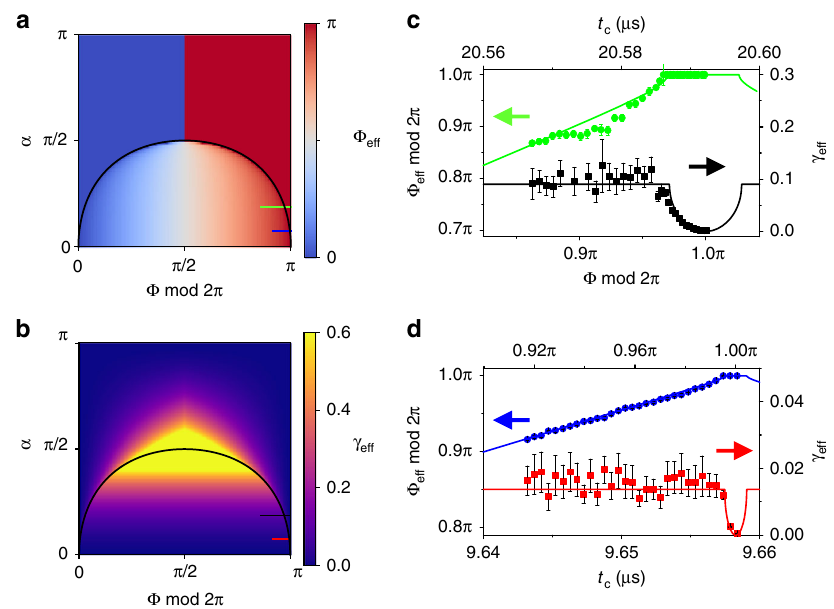
Fig. 3 Quantum dynamics phase transition between oscillating and trapped dynamics. The theoretical results of a the effective precession angle per cycle Φ ¼ 2 π ν t and b the effective decay per cycle γ of the correlation functions versus the conditional phase shift α and nuclear precession angle per (cid:4) (cid:5) eff eff c eff ¼ sin 2 Φ . The short horizontal lines indicate the parameter ranges of measurement cycle Φ ¼ 2 π (cid:2) ν t . The black curves show the phase boundary tan 4 α c 2 the experimental data in ( c ) and ( d ). c The experimental oscillation frequency (green circles) and decay per cycle (black squares) of the correlation ¼ 100), compared with the theoretical results (curves) as functions of the function as functions of the measurement cycle duration t c for KDD5 control ( N p for α ¼ 0 : 186 π , d The same as ( c ) but for KDD2 control in the experiment (blue circles denote nuclear spin precession angle per cycle Φ ¼ 2 π (cid:2) ν t c ¼ 40, corresponding to α ¼ 0 : 0743 π in theory). The the experimental oscillation frequency, red squares the decay per cycle). The number of pulses is N p ¼ 1 : 142 kHz and A ¼ 16 kHz for determining Φ and α in theory are nuclear spin, the dynamical decoupling (DD) sequences and the fi tting parameters A ? Z the same as in Fig. 2. All error bars were calculated as explained in Supplementary Note 5. Source data are provided as a Source Data fi